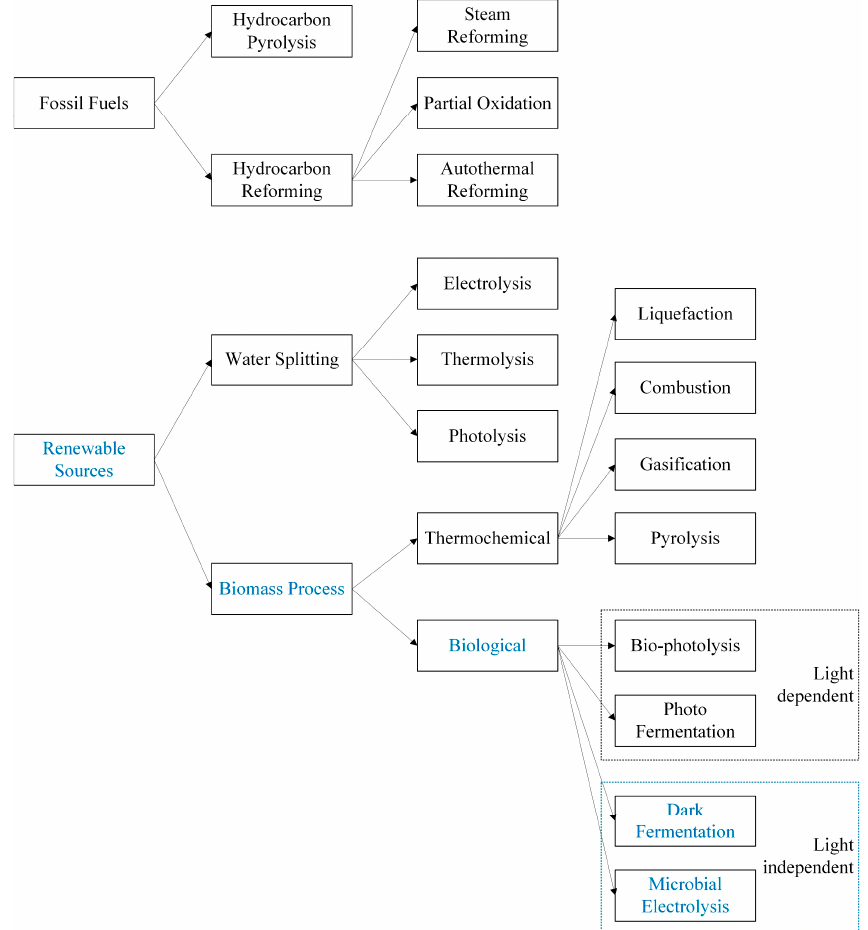
Figure 1. H 2 production methods.